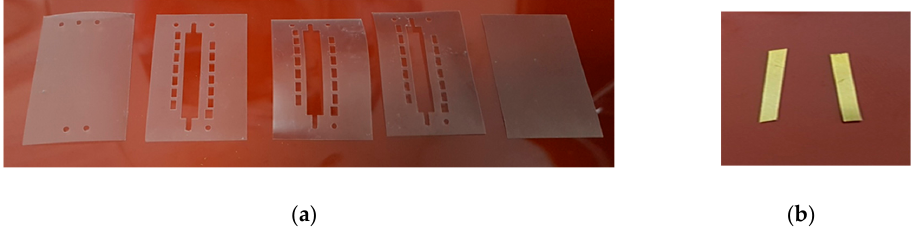
Figure 5. ( a ) Separate layers of PVC foil for inductor fabrication: bottom—PVC layer, middle layer—microfluidic channel, top layer—for inlet, outlet and electrical terminals, ( b ) conductive segments for solenoid turns from one side as well as from another side of the microfluidic channel.